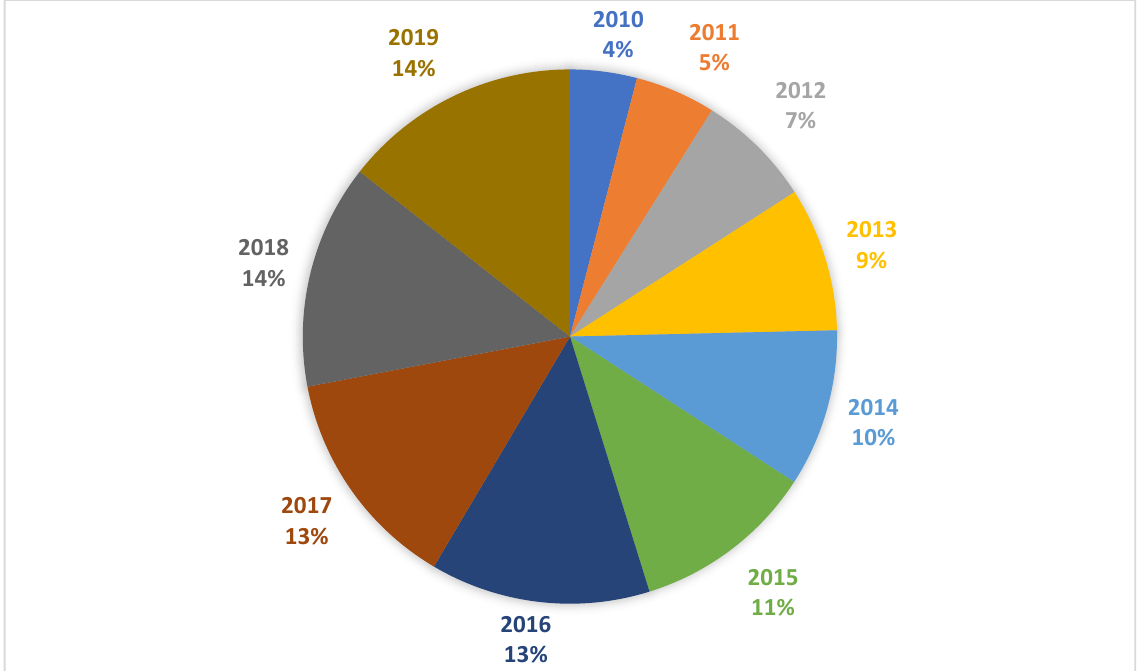
Figure 5. Poland RES capacity installed total 2010–2019 [49].